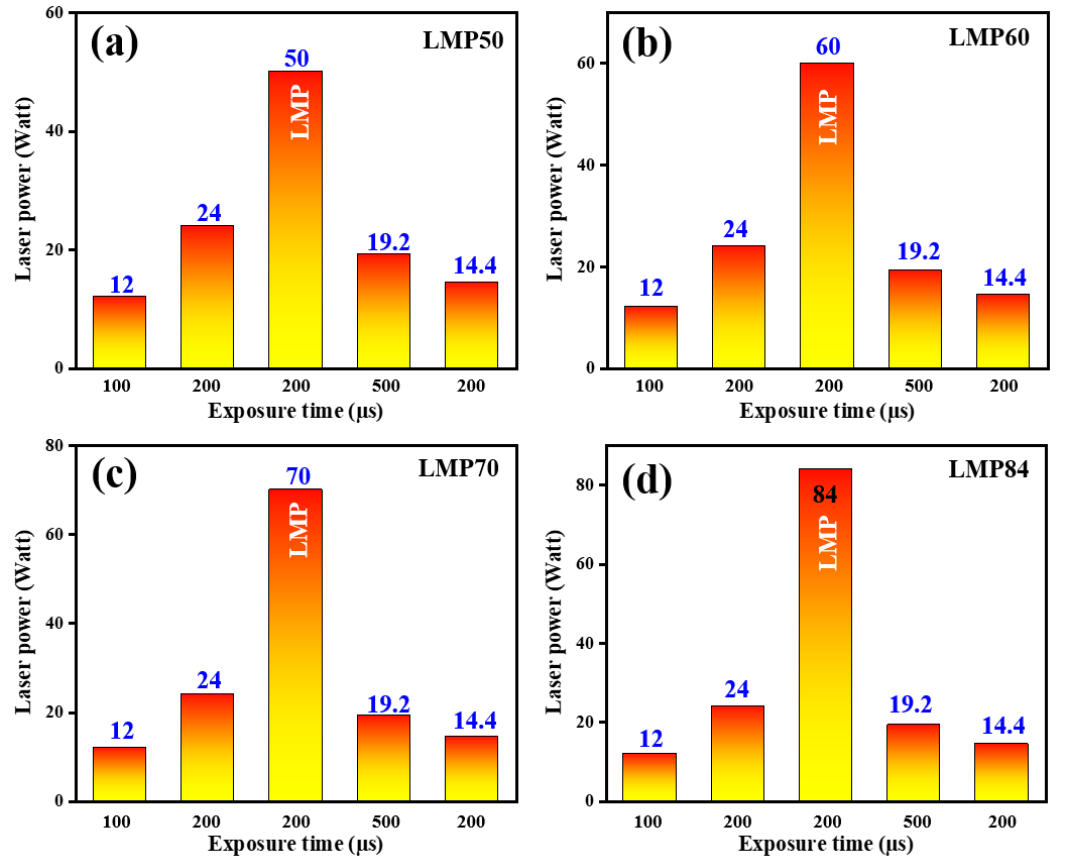
Figure 3. Pulse shaping parameter showing the detail of a single pulse employed for the fabrication of TiC–Fe-based cermets with different laser melting peaks power (LMP) ( a ) LMP50, ( b ) LMP60, ( c ) LMP70, and ( d ) LMP84.